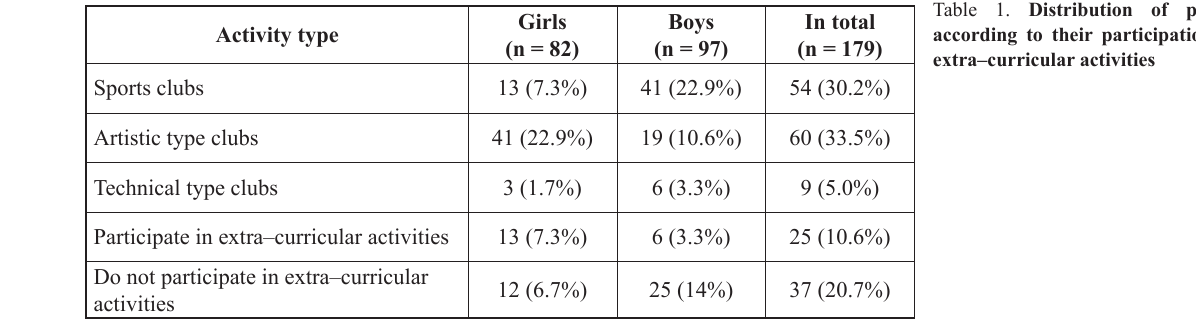
Table 2. Differences in the expression of pro-social behaviour components according to participation in extra-curricular activity and its type